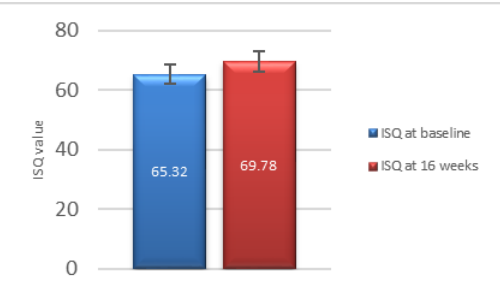
Figure 10: Mean of primary and secondary stability.